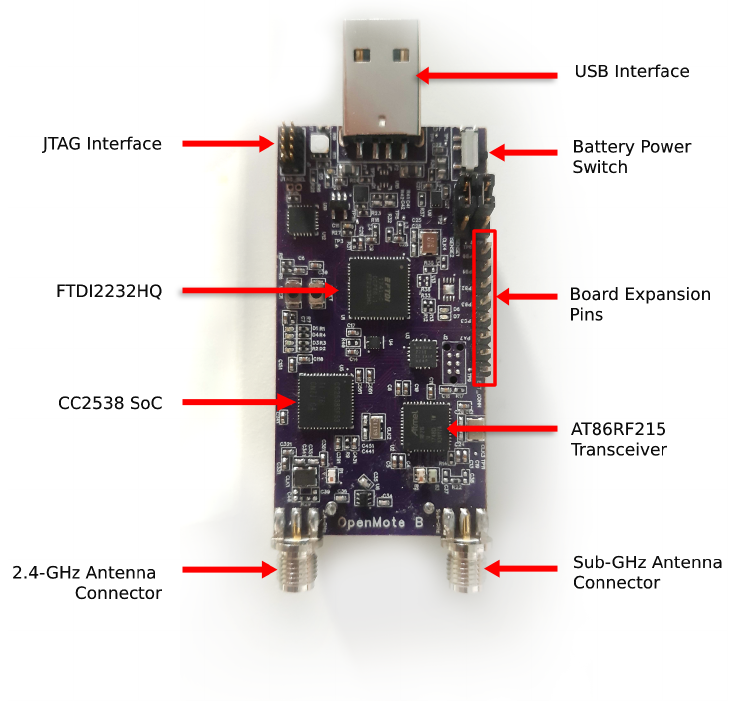
Figure 7. The OpenMote B board, used for running